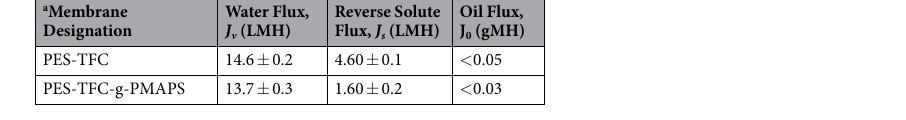
Table 1. Performance of the single-skinned (PES-TFC) and double-skinned membrane (PES-TFC-g-PMAPS). a Both membranes were evaluated at AL-DS mode; Draw solution: 2 M NaCl; Feed solution: 10,000 ppm of oil water solution.